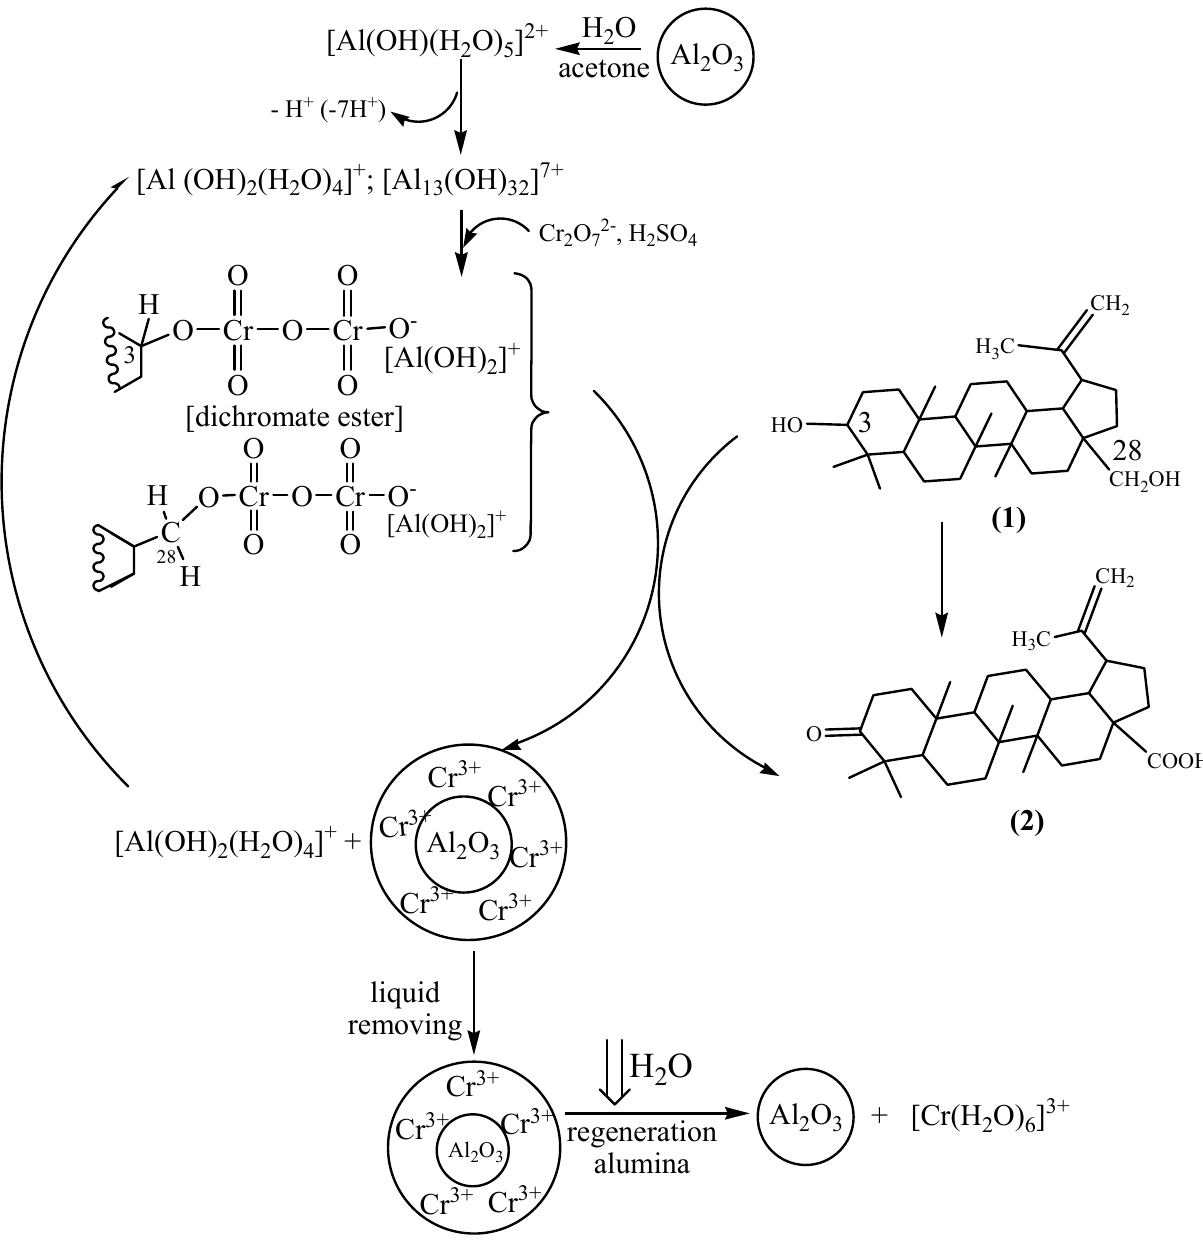
Cr O –H SO 2 2 7 2 4